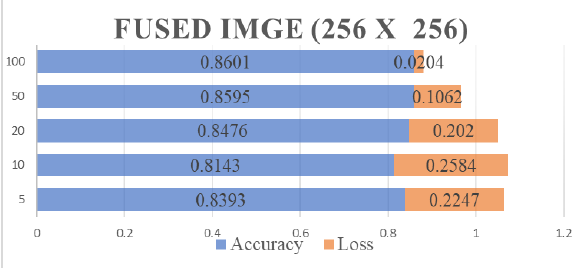
Figure 19 . Graph of Fused Image (256 X 256). As per the graph fig.20, with the different epochs, the accuracy and loss are also different for this window size we get approx. features within the image.